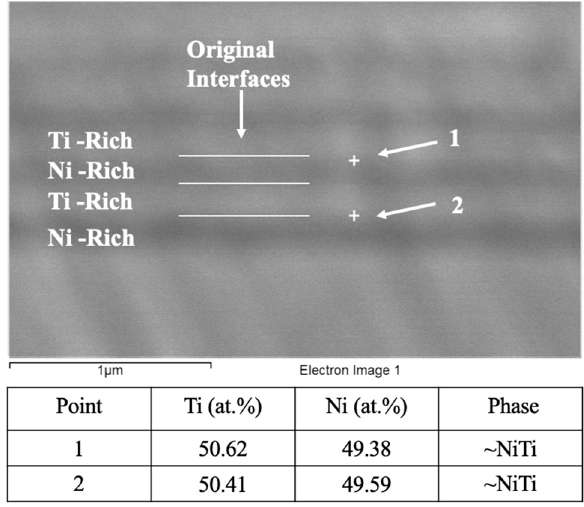
Figure 5. Energy dispersive spectrometry (EDS) of 650 °C nanolaminate cross-section.